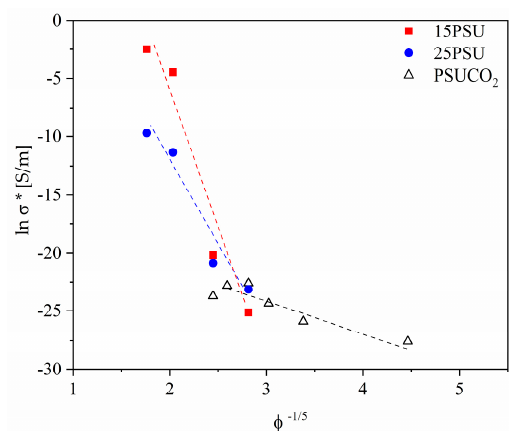
Figure 5. Representation of the fitting results of the electrical conductivity versus φ − 1/5 , demonstrating the tunnel conduction characteristics of a 3D random particle distribution system formed by conductive GnP stacks.